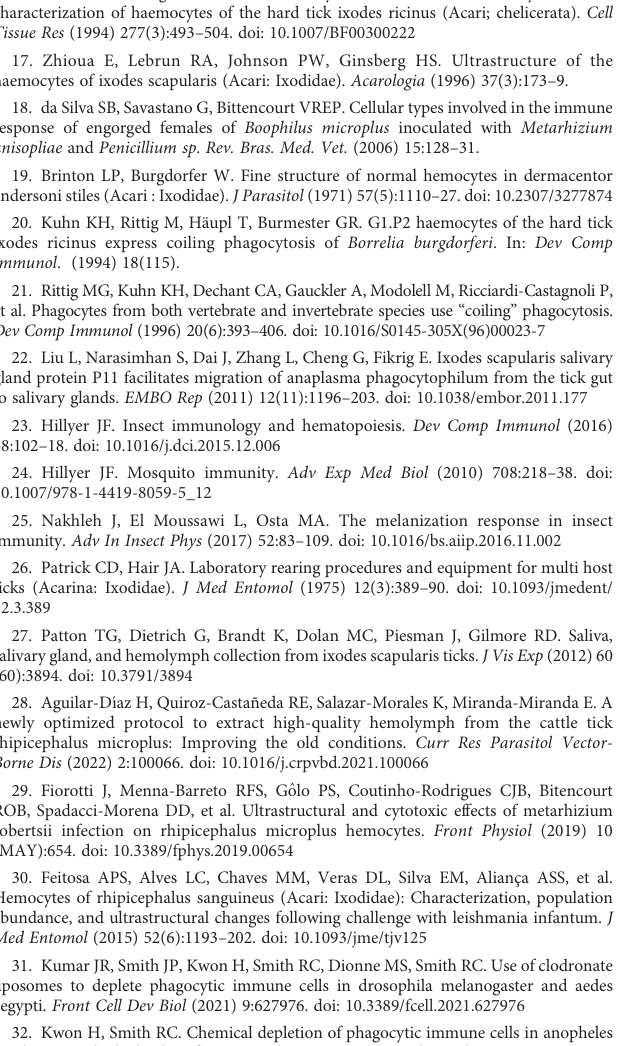
transcriptional and (B) humoral regulators of hemocyte differentiation and maturation. Thescale barshowsthe log 2 foldexpression valueof thetranscripts. SUPPLEMENTARY FIGURE 5 Heatmap of RNA-seq expression data showing differentially expressed transcripts in the toll-signaling pathway in R. parkeri infected and uninfected hemocytes. Six of the nine Toll genes were identi fi ed including eight PGRP transcripts. Transcripts encoding GNBP , tube , and pelle were, however, not present. The scale bar to the right shows the log 2 fold expression value of the transcripts. SUPPLEMENTARY FIGURE 6 Heatmap of RNA-seq expression data showing differentially expressed transcripts in the IMD signaling pathway in R. parkeri- infected and uninfected hemocytes.Sequencesencoding IMD ,Fas-associated via deathdomain( FADD ). and death-related ced-3/Nedd2-like caspase ( DREDD ) genes were absent from our data. The scale bar to the right shows the log 2 fold expression value of the